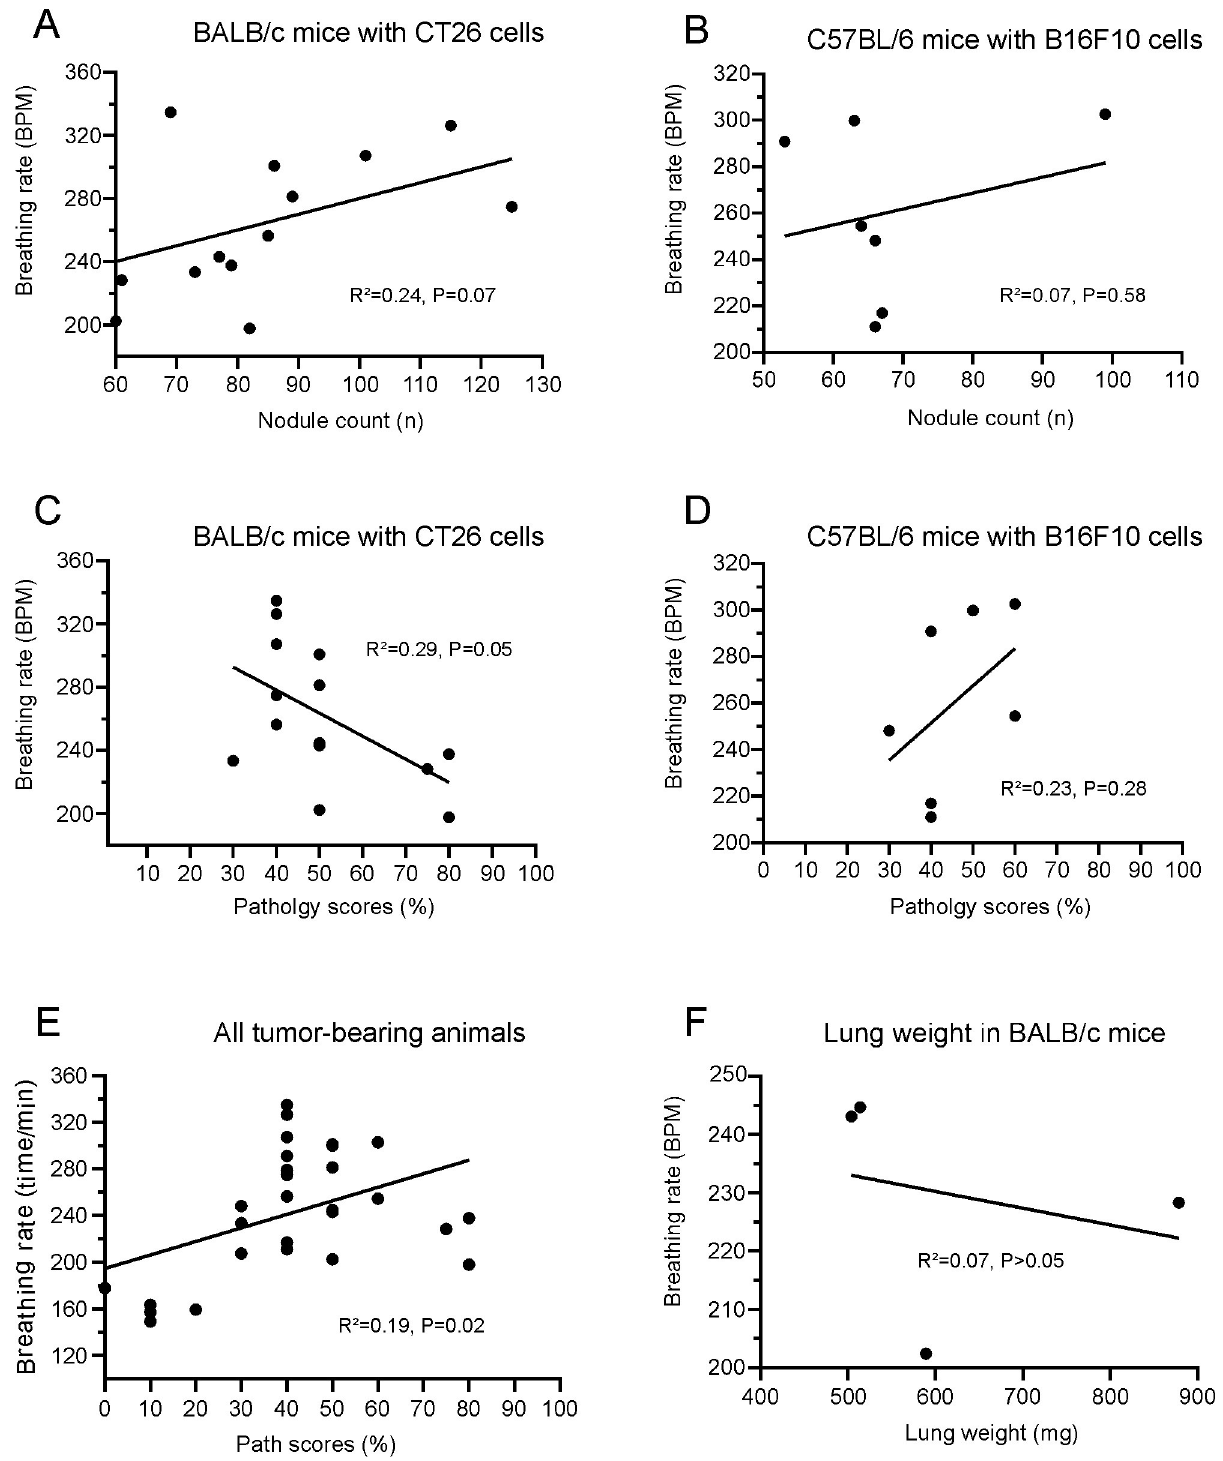
Fig 4. No correlations of increased breathing rates to lung tumor nodule counts, pathology score and weight in BALB/c and C57BL/6 mice. The increased breathing rates were not correlated to either lung surface tumor nodular counts (A&B), pathology scores ( > 30%, C&D) or lung weights (F, all P > or = 0.05). However, when the data from tumor-bearing animals with pathology score < 30% were included, the breathing rate and pathology score were significantly correlated (E).